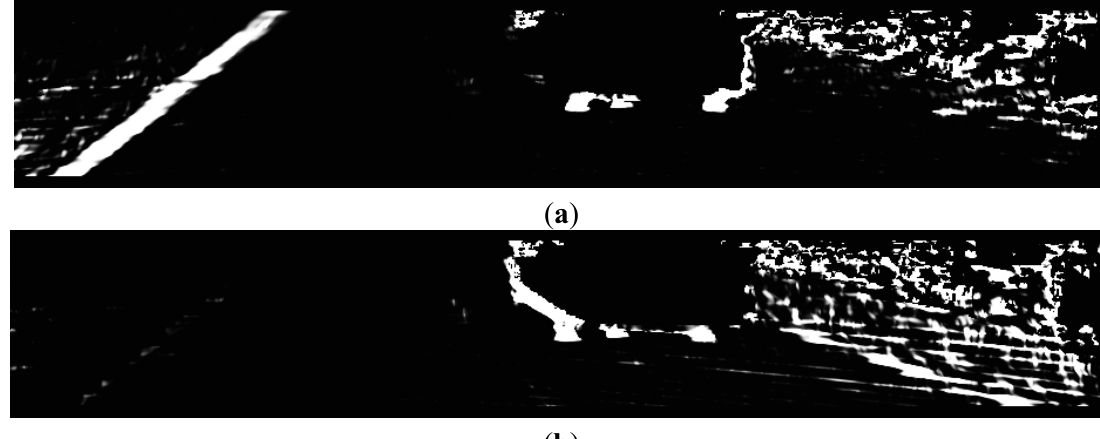
Figure 13. ( a ) Node probability for left side curb; ( b ) Node probability for right side